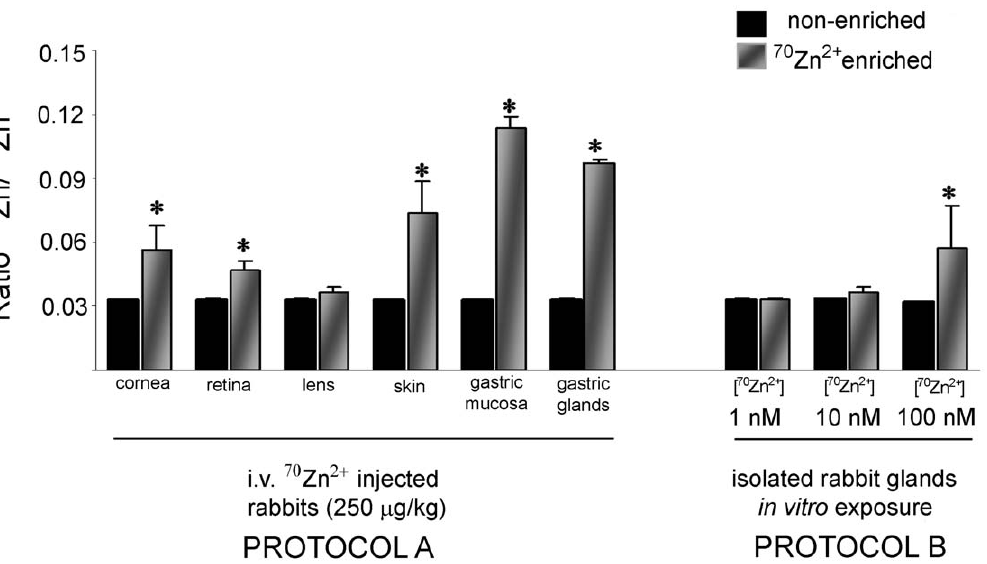
Figure 3. Acquisition of 70 Zn in tissues and isolated gastric glands of the rabbit. Measurements of isotopic Zn species by ICP-MS are reported as the ratio of 70 Zn/ 68 Zn (no dimensions) means 6 SD, *p , 0.05 compared to control measurements. Protocol A . Measurements in tissues harvested from rabbits: three control (black columns) and in three rabbits 18 hrs after intravenous infusion of 70 ZnCl 2 (250 m g/kg). Protocol B . Measurements performed in aliquots of gastric glands exposed to standard Ringer’s containing EGTA, Ca 2 + (calculated free concentration 1 mM) and reagent ZnCl 2 (control) or 70 ZnCl 2 (calculated free concentrations 1 nM, 10 nM or 100 nM).